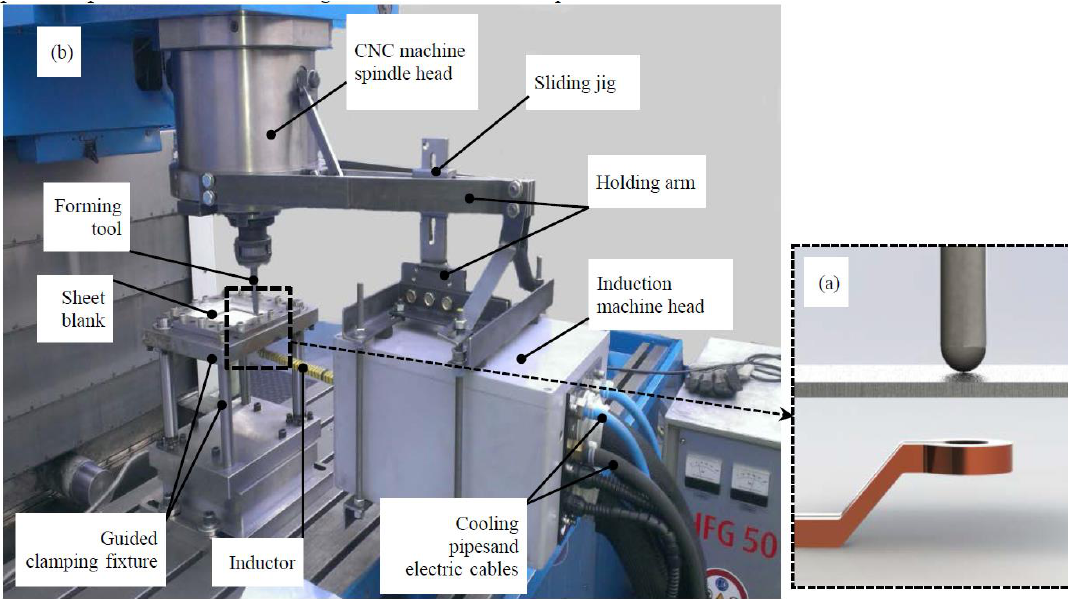
Figure 1. Experimental setup applied in the investigations for IASPIF process. ( a ) Close up of forming tool and sheet blank; and ( b ) entire setup.